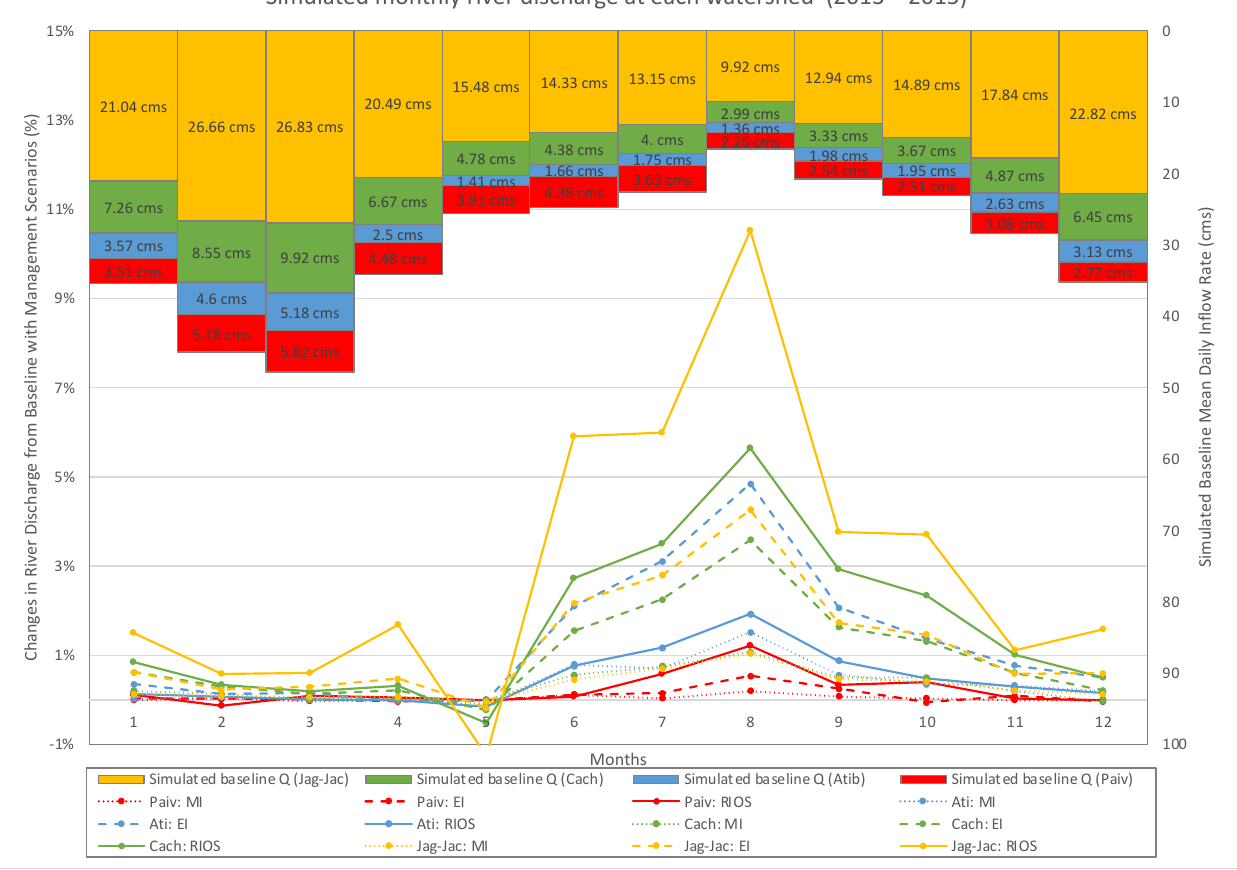
Figure 10. Average monthly river discharge and the changes with each scenario (minimum intervention (MI); enhanced intervention (EI), and RIOS) at each watershed outlet location (Jaguari – Jacarei (Jag – Jac), Cachoeira (Cach), Antibainha (Ati), and Paiva Castro (Paiv) reservoirs) from HEC-HMS simulations for ( a ) the entire simulation period and ( b ) drought years 2013 – 2015.